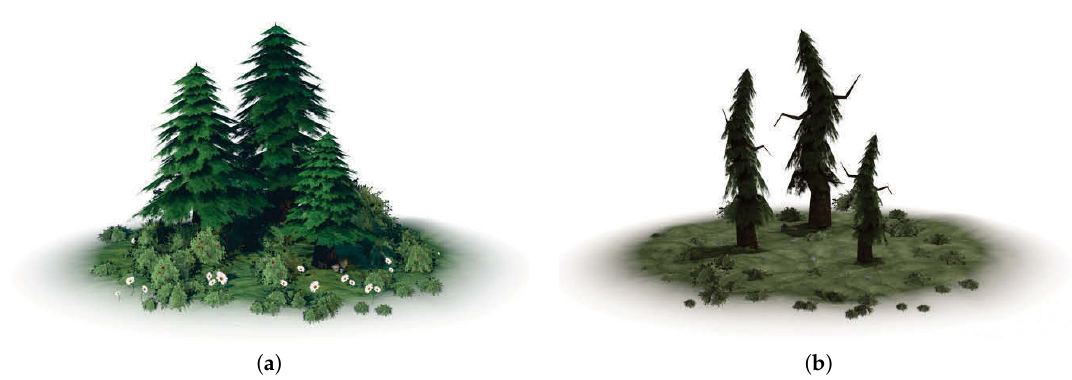
Figure 5. An example of an eco-visualization showing a healthy tree ( a ), which can die ( b ) because of bad energy consumption behavior. Images from Reference [34].